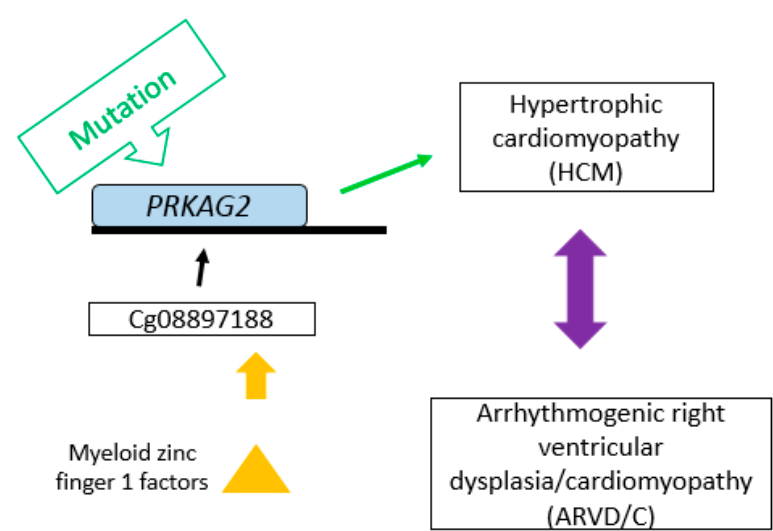
Figure 4. Possible mechanism of association of cg08897188 with CVD. Cg08897188 is involved in regulation of the PRKAG2 gene. Mutation of PRKAG2 can cause HCM or ARVD/C. Cg08897188 has a specific region able to bind myeloid zinc finger 1 factor, which is also associated with ARVD/C. The cg04580029 is located in the promoter flank of KREMEN2 gene, only 3 bp away of the TSS (p2@KREMEN2—Figure 2B). The observed overlap with a H3K27Ac histone peak which is a mark